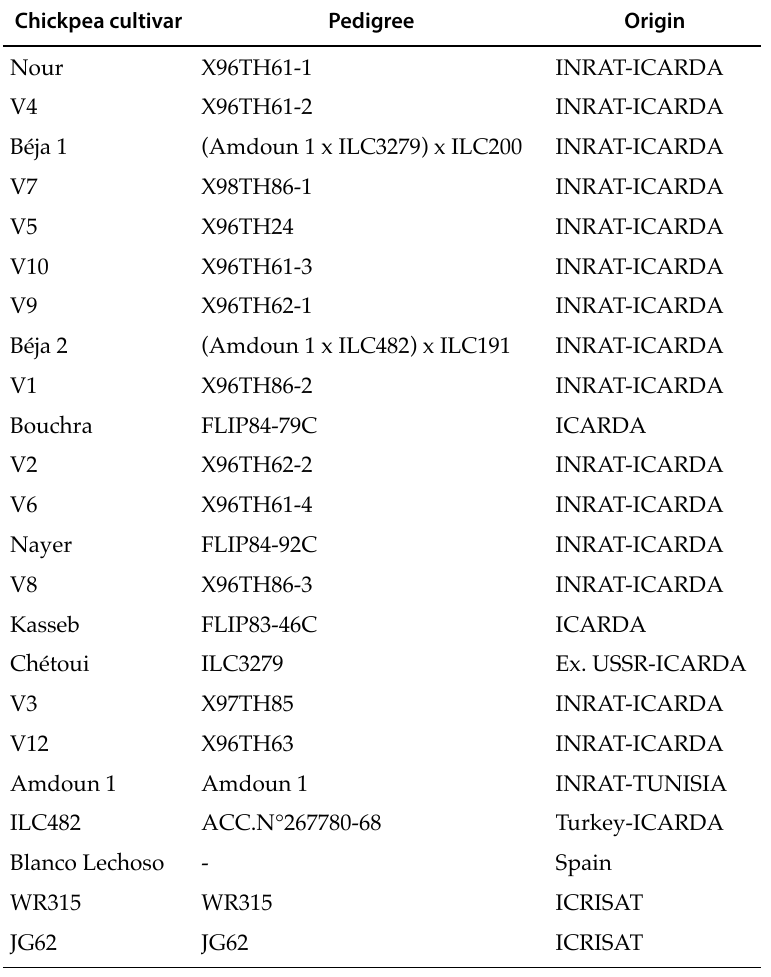
Table 1. Pedigree and origin of the 23 chickpea cultivars and advanced lines